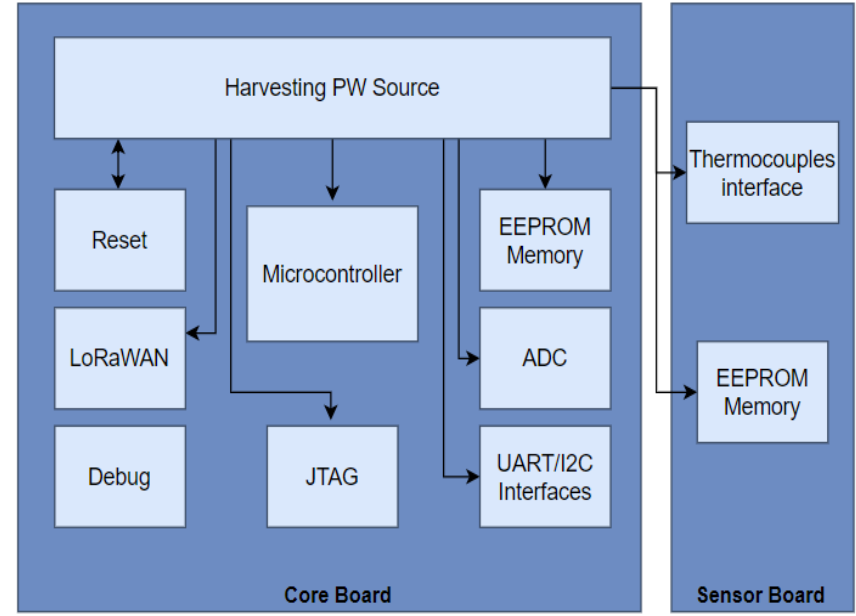
Figure 2. Block diagram of the hardware design.